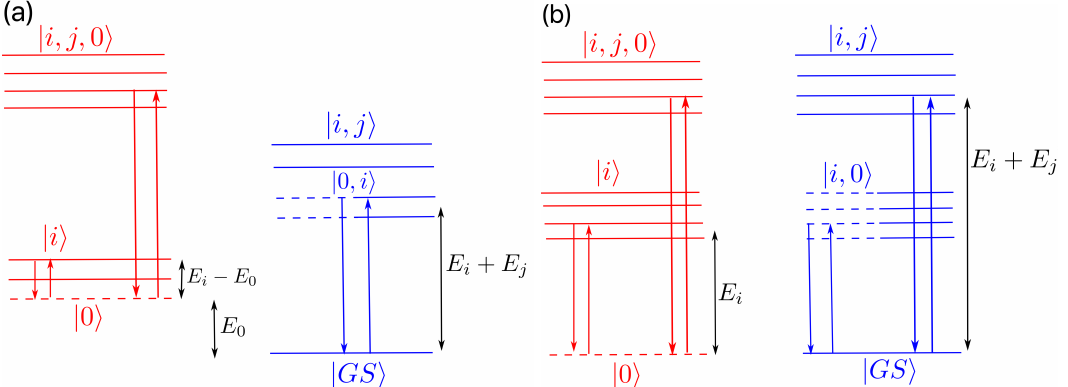
Figure 6: (a) Schematic view of the spectrum of the open transverse Ising chain in < B . Energy transitions can occur between the even ground the trivial regime J ( 1 ) x state | GS 〉 and the two particle excitations with energy difference E E can be also E . Energy transitions are also possible between the lowest odd parity j 0 state | 0 〉 and the single particle excitations with smaller energy difference E or between the single particle excitations and many particle excitations with higher + E energy difference E . (b) Schematic view of the spectrum in the transverse Ising i j > B with the zero-energy mode E open chain in the topological regime J ( 1 ) x